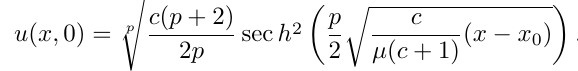
collocation points the errors decrease. Later, we set N = 400 and decrease time step size to see convergence in temporal variable. Obtained re- sults are given in Table 2 where one can see that by halving the time step size the errors decrease and convergence orders are about two which is theoretical convergence order of Crank-Nicolson method. In Table 3, for N = 100, c = 0 . 1, ∆ t = 0 . 05 and p = 2 , 3 the error norms are given at dif- ferent final times with CPU times taken during simulation. Accuracy of the results can be seen from the table. Table 4 indicates variation in the invariants for N = 400, ∆ t = 0 . 1, c = 0 . 1 and p = 2 , 3 at different final times. From the table one can conclude that the proposed method can conserve invariants quite good. In Tables 5 and 6 the invariants and errors are calculated and compared with ones of septic B- spline collocation method [24] for ∆ t = 0 . 01, µ = 1 ,p = 4, c = 0 . 3 and N = 250 (in case of the present method), h = 0 . 1 (in case of the method of [24]). Absolute differences of I 1 , I 2 , I 3 between initial time t = 0 and final time t = 10 are approximately 2 e − 07, 2 e − 06, 2 e − 06, re- spectively for the method of [24] while these differ- ences are approximately 2 e − 07, 4 e − 07, 1 . 2 e − 06, respectively for the present method. In Table 7, a comprehensive comparison between B-spline fi- nite element [23], cubic B-spline collocation [6], Petrov-Galerkin [22], septic B-spline collocation [24] methods and the present method is given for p = 2 , 3 , 4. For present method we take N = 250 while for the other methods space step size h is taken as 0 . 2 and 0 . 1. From the table it is clearly seen that for p = 3 lowest errors are obtained by the present method and for p = 2 , 4 lowest errors are obtained by the method of [24]. Finally in Table 8 a comparison with compact finite differ- ence [20] is given for ∆ t = c = 0 . 1 where accuracy of the present method is obvious. In Figs. 2 and 3, motion of single solitary waves are given for p = 3, c = 1 . 2 and p = 4, c = 4 / 3, respectively. It can be seen that at t = 0 the solitary wave is located at x 0 = 40 and as time goes the single solitary wave moves rightward with constant speed and with almost invariable ampli-